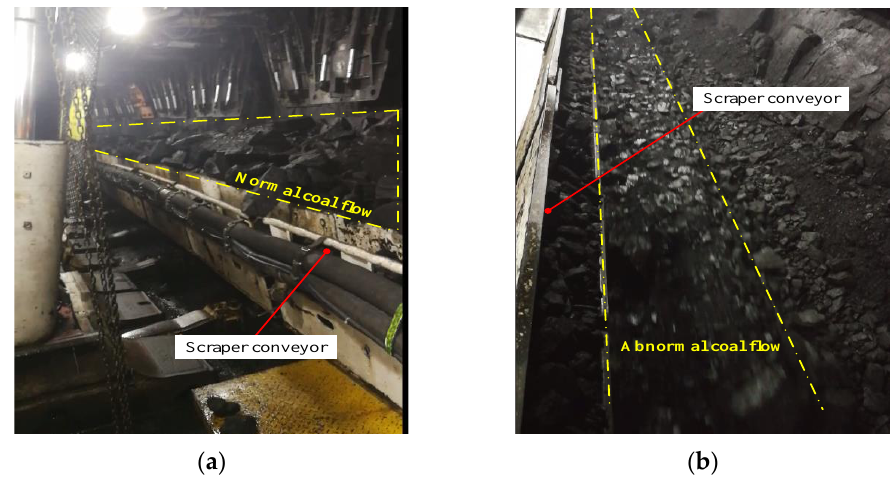
Figure 2. Scraper conveyor coal flow: ( a ) Normal coal flow; ( b ) Abnormal coal flow.